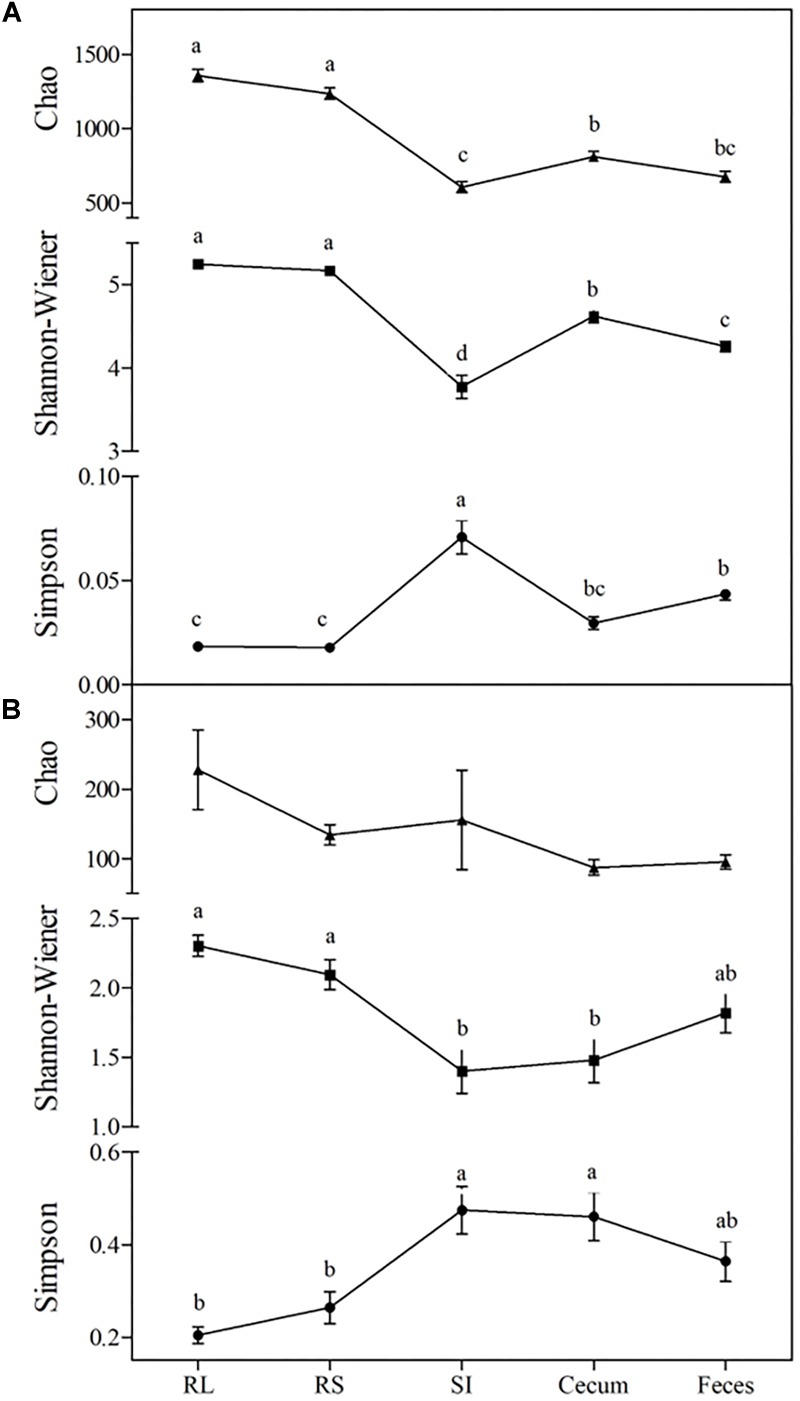
Changes in alpha-diversity of bacterial (A) and fungal (B) communities across the GIT of Nelore steers. Triangles represent Chao richness, squares represent Shannon-Wiener diversity and circles represent Simpson’s diversity index. For each index, means followed by at least one same letter did not differ at a 5% level of significance as determined by Tukey’s test. RL, rumen liquid; RS, rumen solids, and SI, small intestine.